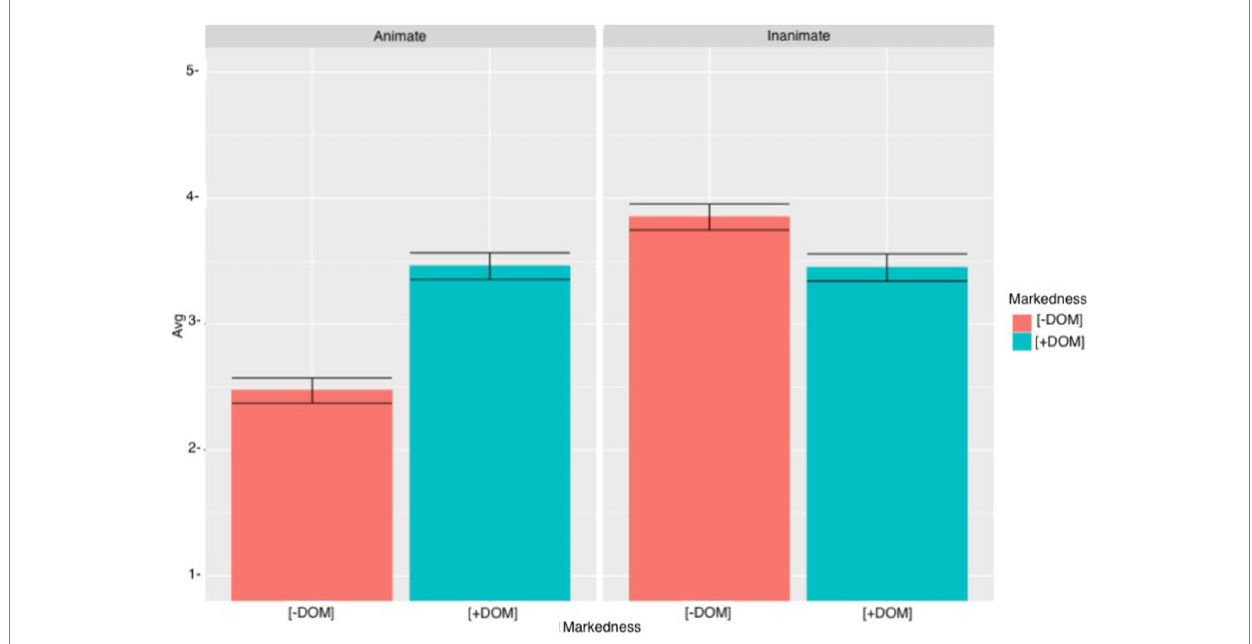
FIGURE 7 Heritage speakers means acceptability scores and errors bars (95% CI) for VSO sentences.